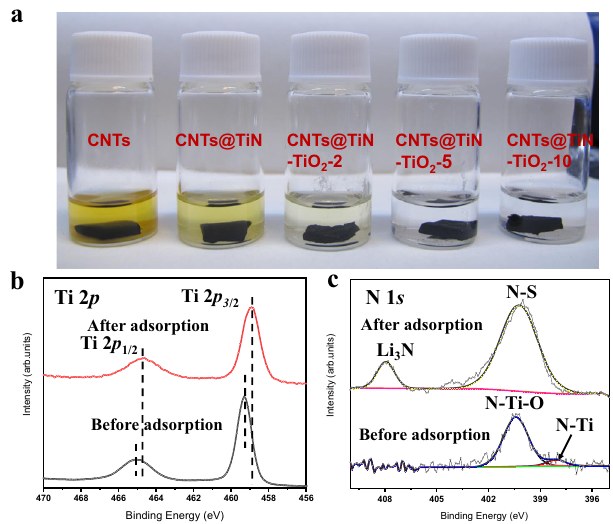
Fig. 3 Lithium polysul fi de adsorption visual test and corresponding